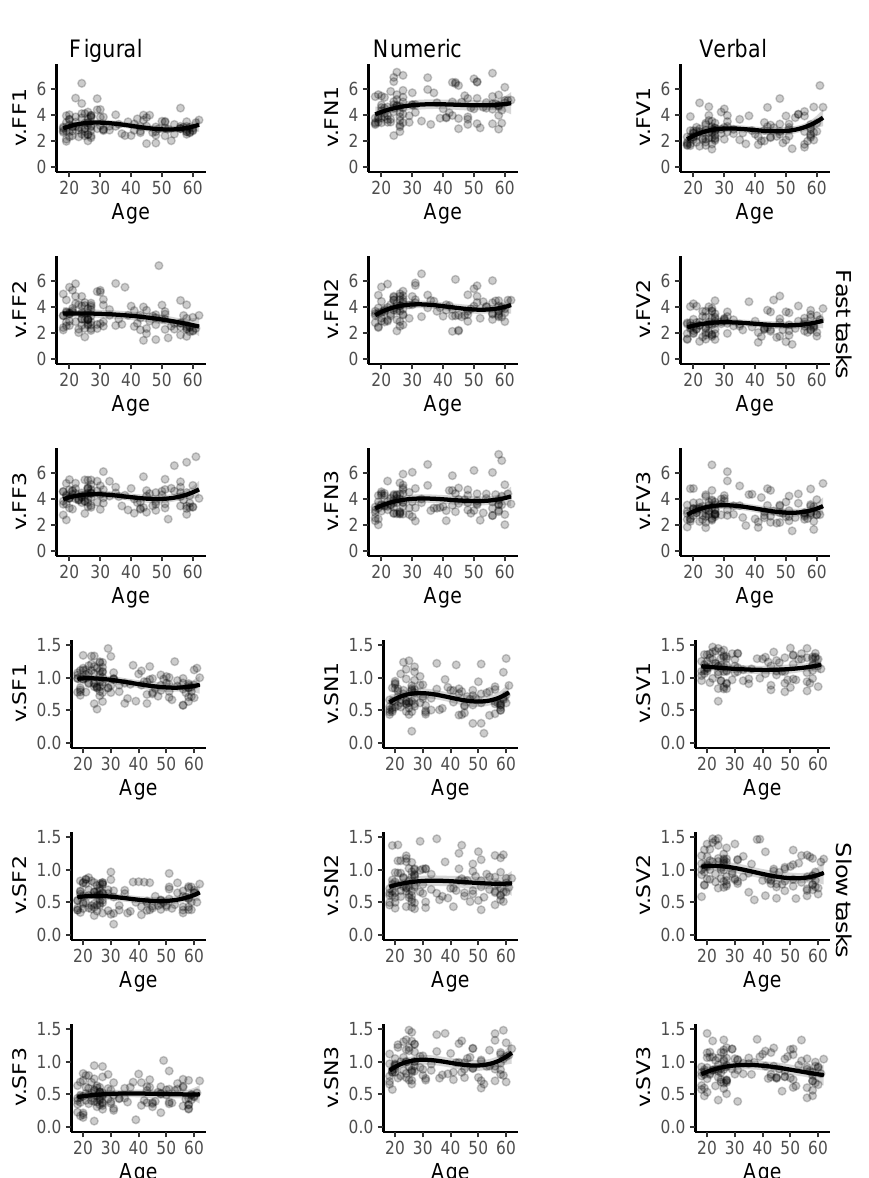
Figure A5. Scatterplots of drift rate vs. age in the 18 different tasks. See Table 1 for task descriptions. The trends show results from a polynomial regression of third